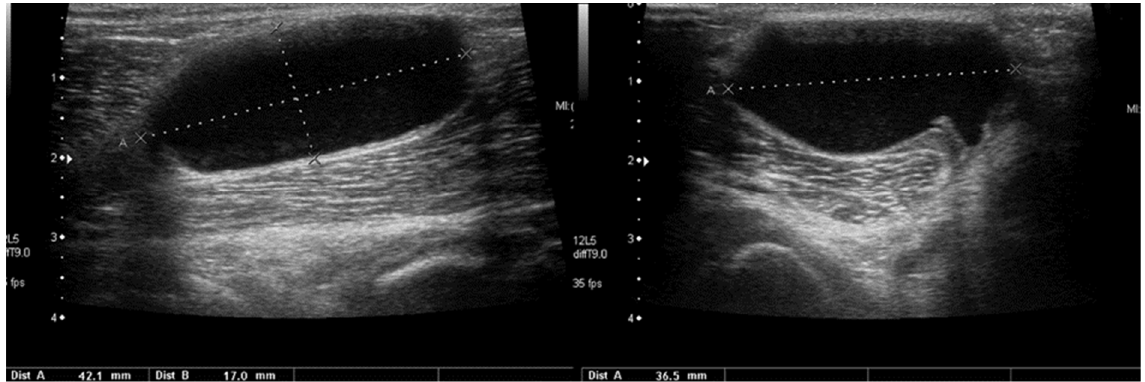
Figure 18. Longitudinal ( left ) and transverse ( right ) views of a Baker’s cyst in the right popliteal fossa of an 11-year-old boy.